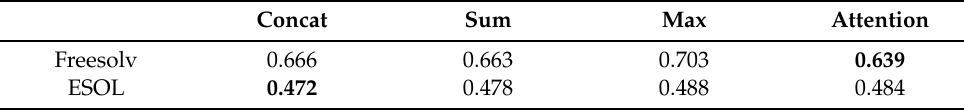
Table 4. Averages of MAE for aggregation approaches.